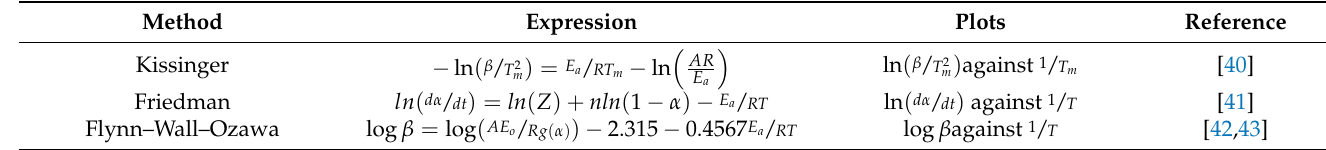
Table 1. Methods for calculating the kinetic parameters using TGA data. Method Expression Plots